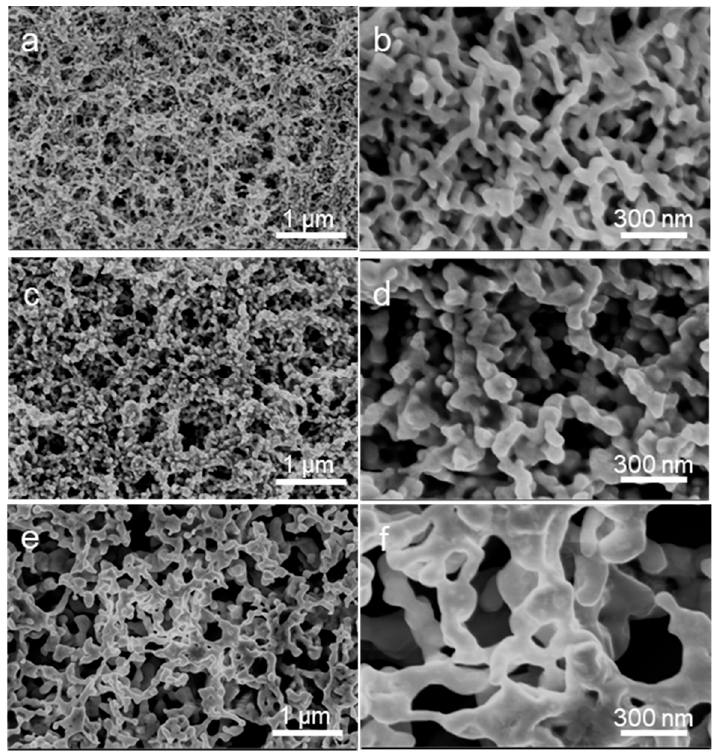
Figure 3. SEM images of the NPG electrode annealed at different temperatures: ( a , b ) 200 °C, ( c , d ) 300 °C, ( e , f ) 400 °C. ( c , d ) 300 ◦ C, ( e , f ) 400 ◦